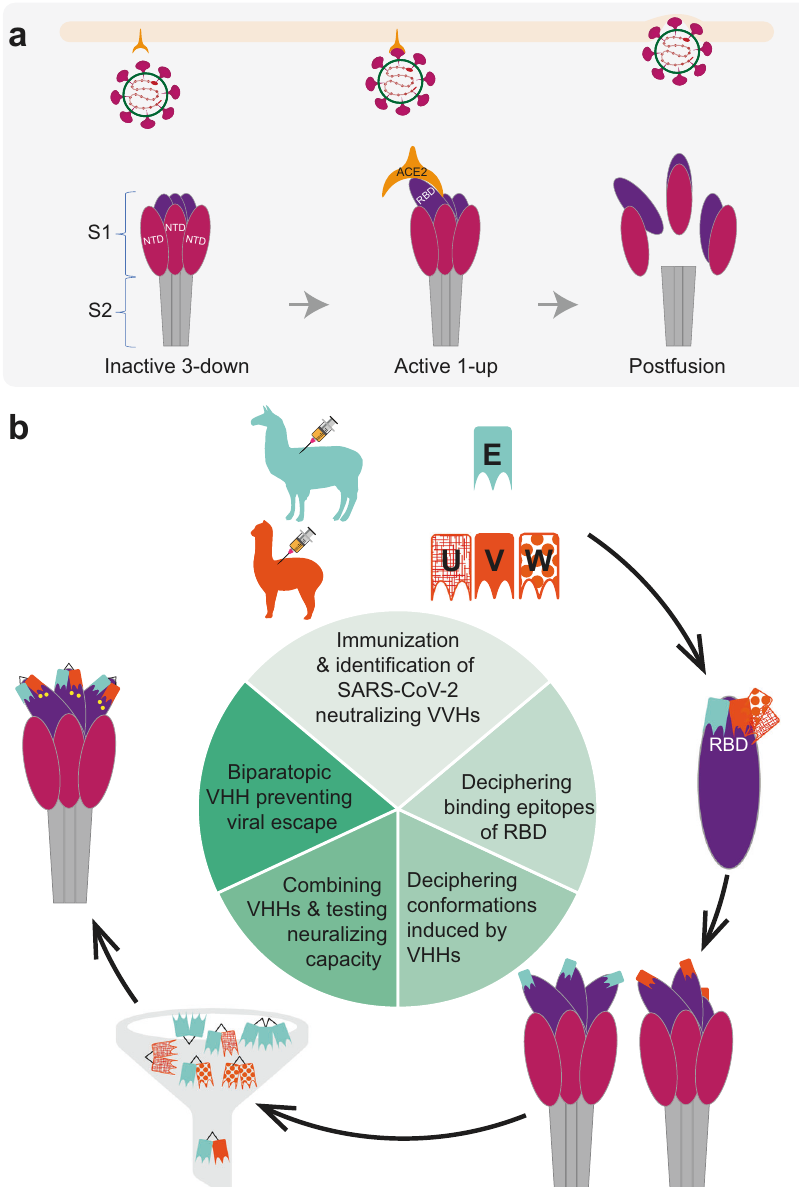
Fig. 1 Cartoon showing the rational engineering of nanobodies. a The spike protein consisting of the S1 and S2 subunits. The N-terminal domain (NTD) and the receptor-binding domain (RBD) of the S1 unit during the process of binding to the angiotensin-converting enzyme 2 (ACE2) receptor are displayed (left to right). The ACE2 receptor can only bind to RBD in the up position, the binding of ACE2 triggers the fusion machinery including dissociation of the subunits; b work fl ow to generate SARS-CoV-2-neutralizing biparatopic antibodies that prevent viral